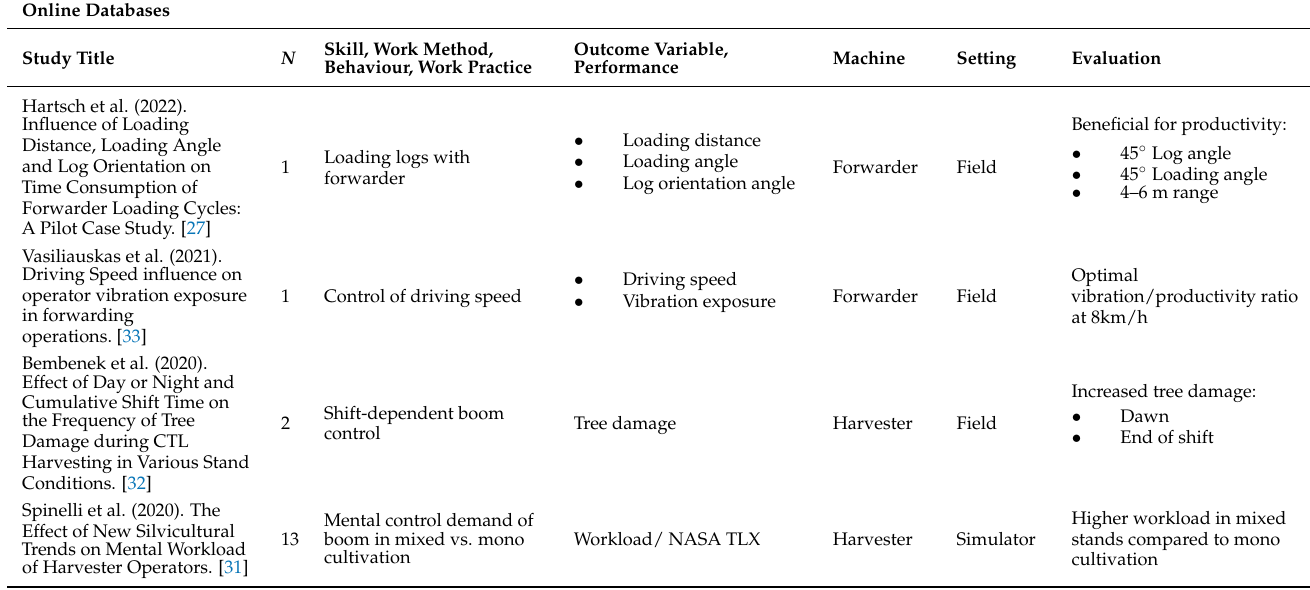
Table 2. Data extracted from the PRISMA literature